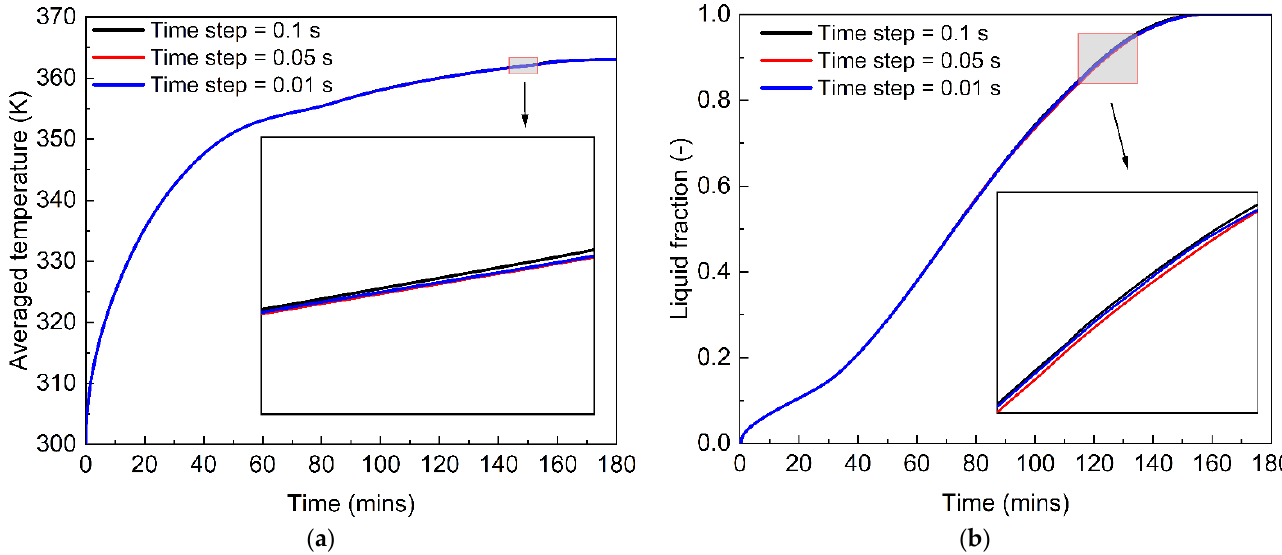
Figure 4. Effect of time step on the computational results of the melting process of phase change materials. ( a ) Average temperature; ( b ) Liquid fraction. materials. ( a ) Average temperature; ( b ) Liquid